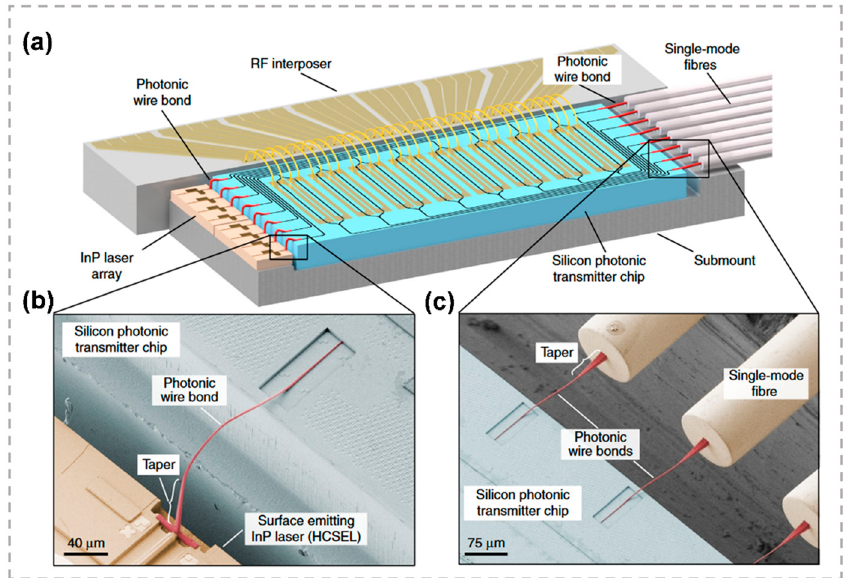
Figure 13. ( a ) Concept and implementation of hybrid multi-chip modules by 3D nano-printing of photonic wire bonds. ( b ) Interface between an InP laser chip and the silicon photonic transmitter chip. ( c ) Fiber-to-chip interface [137]. Reproduced from [137] with permission of the Springer Nature,